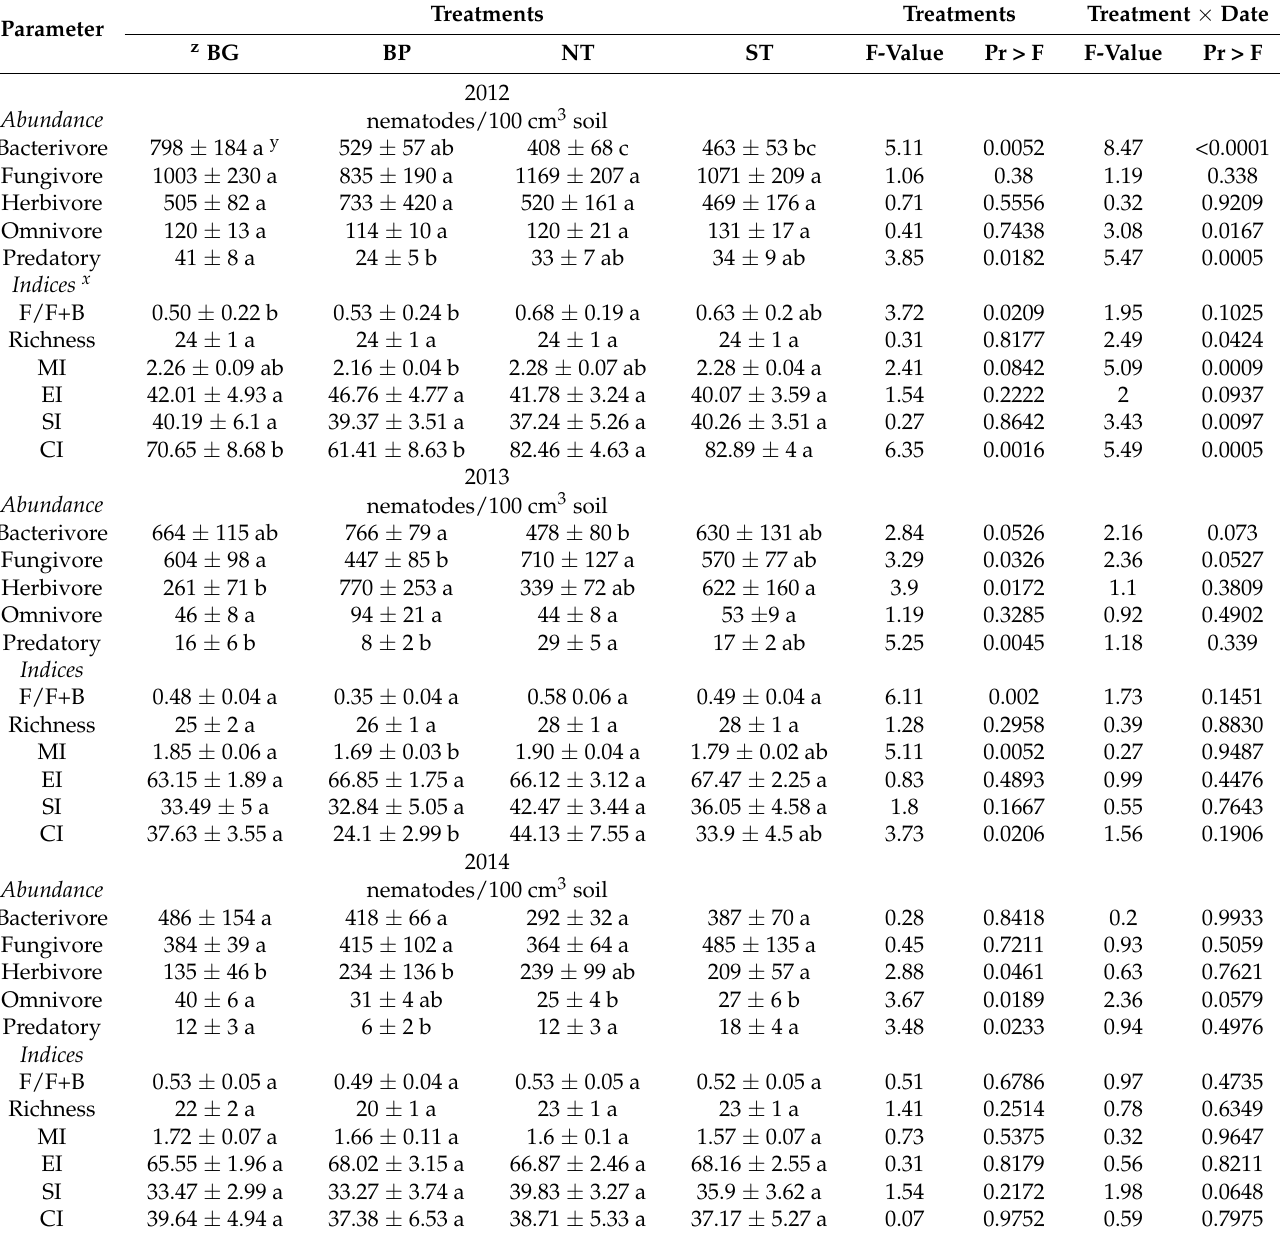
Table 2. The effect of plasticulture and tillage treatments on nematode community in 2012, 2013, and